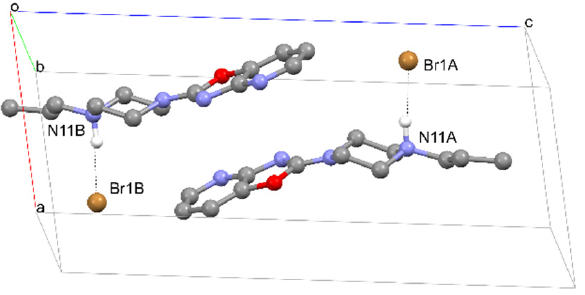
Figure 16. The intermolecular hydrogen bonds in compound 6 .